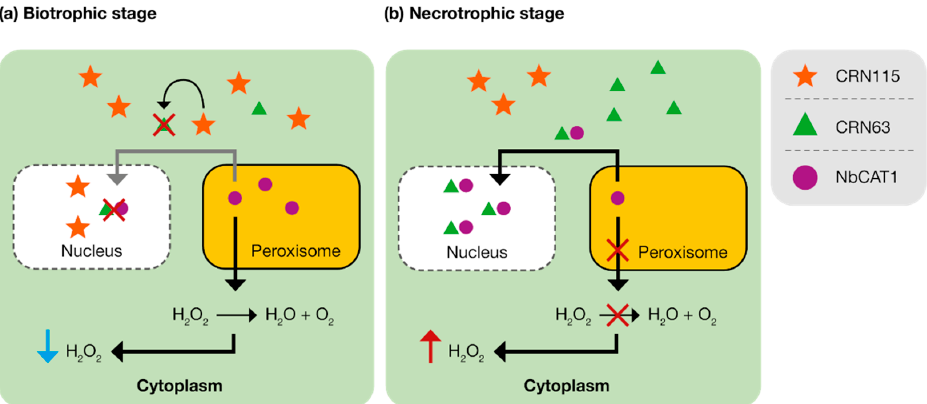
Figure 6. Schematic of how CRN63/115 modulates PCD in Nicotiana benthamiana . ( a ) During the early stages of infection (biotrophic stage), CRN115 inhibits the activity of CRN63, preventing the relocation and scavenging of NbCAT1. NbCAT1 is then able to convert H 2 O 2 into water and oxygen. Inhibiting H 2 O 2 accumulation induced by CRN63. ( b ) CRN63 is slightly induced during the late stages of infection (necrotrophic stage) and relocates NbCAT1 to the nucleus where NbCAT1 is destabilized and therefore unable to convert H 2 O 2 into water and oxygen. This results in an accumulation of H 2 O 2 in the cytoplasm, resulting in PCD.